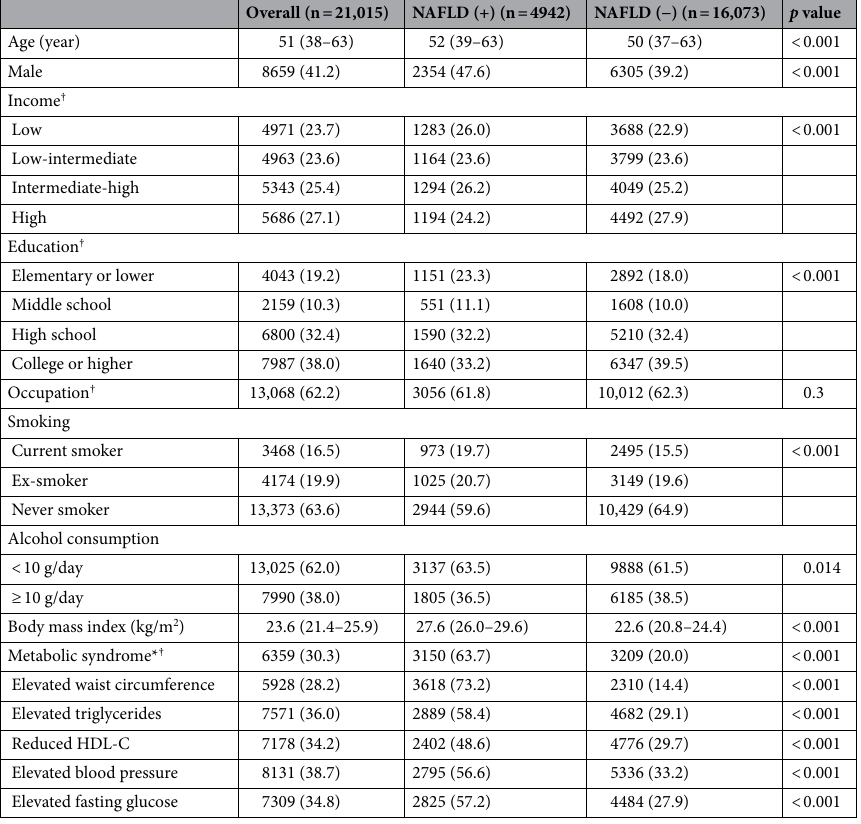
Table 1. Baseline characteristics of study participants by non-alcoholic fatty liver disease status (n = 21,015). Values are expressed as number (%) or median (quartile). NAFLD non-alcoholic fatty liver disease, HDL-C high-density lipoprotein. *Metabolic syndrome was defined when any three of five risk factors were present: elevated waist circumference: ≥ 90 cm for men, ≥ 85 cm for women; elevated triglycerides: ≥ 150 mg/dL or use of antidyslipidemic medications; reduced HDL-C: < 40 mg/dL for men, < 50 mg/dL for women; elevated blood pressure: ≥ 130/85 mmHg or use of antihypertensive medications; elevated fasting glucose: ≥ 100 mg/dL or use of antidiabetic medications. † These variables had missing value. Number of participants with missing value were as follow: income (n = 52), education (n = 26), occupation (n = 12), metabolic syndrome (n =